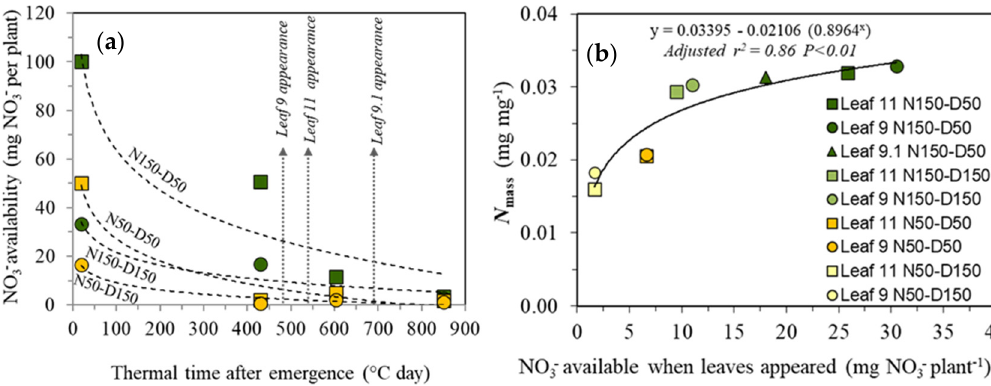
Figure 8. ( a ) Nitrate (NO 3 − ) availability as a function of thermal time since emergence until flowering (vertical arrows represent the moment when leaves evaluated appeared). Fitted functions were as follows: N150-D50, y = 3.60 + 103.90(0.997 x ), ( r = 0.9182); N150-D150, y = 1.41 + 34.27(0.9973 x ), ( r = 0.9407); N50-D50, y = 6.60 + 91.24(0.962 x ), ( r = 0.8695); N50-D150, y = 1.68 + 31.50(0.9620 x ), ( r = 0.9813); ( b ) relationship between N mass and NO 3 − availability at the moment when leaves 9, 9.1, and 11 appeared.